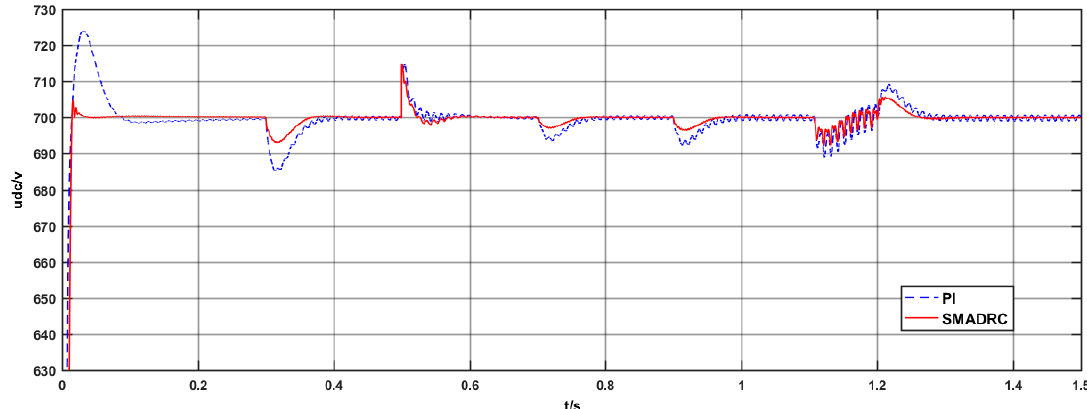
Figure 8. The overall control effect of the two controllers during the simulation period.